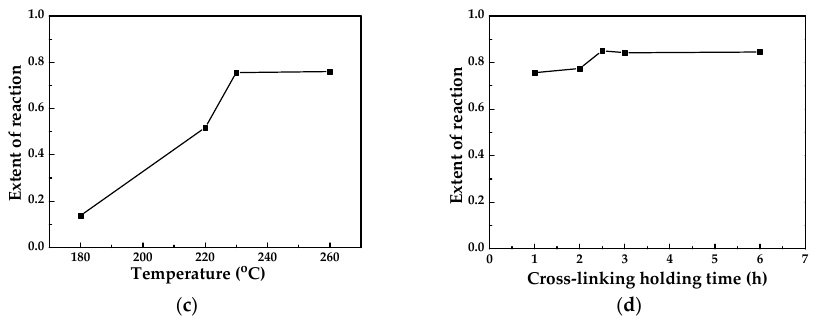
Figure 2. ATR-Fourier transform infrared spectroscopy (FTIR) spectra of the PAN and cross-linking asymmetric (CLA)-PAN membranes obtained at different cross-linking temperatures with the holding time of 1 h ( a ) and the extents of reaction (EOR) data of PAN membranes ( c ). ATR-FTIR spectra of the PAN and CLA-PAN membranes obtained at different cross-linking holding time with the temperature of 230 °C ( b ) and the EOR data of PAN membranes ( d ).